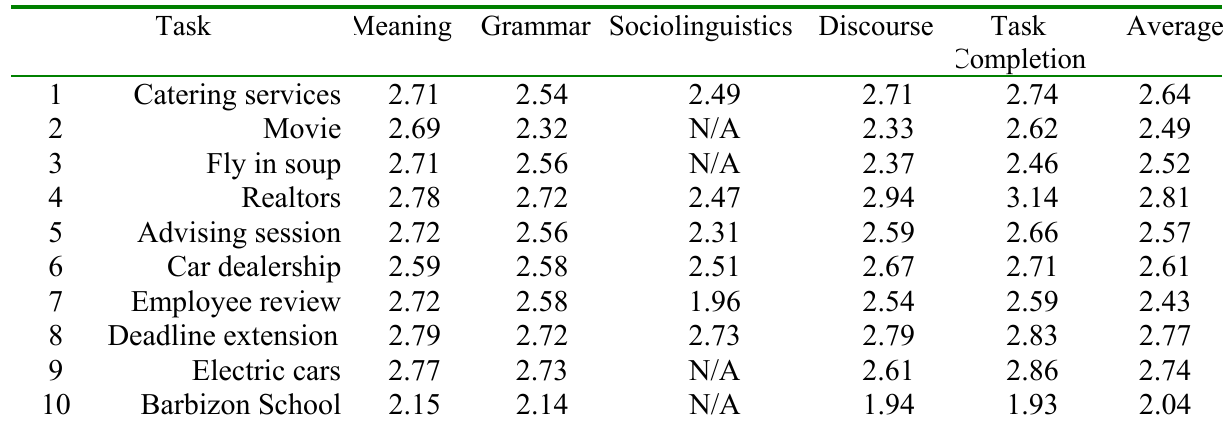
Means for Each Dimension of Language Ability